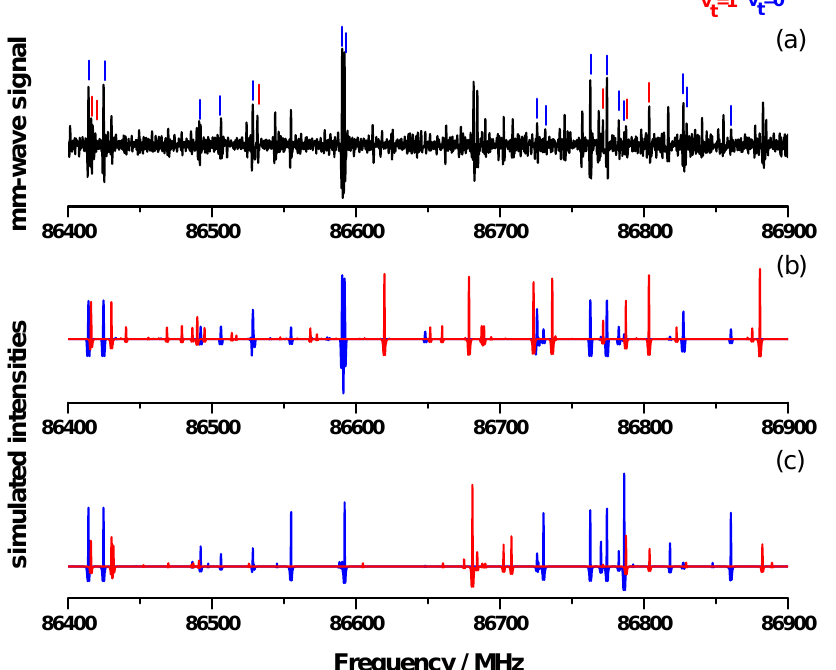
Figure 2. ( a ) Experimental mm-wave spectrum of 2-MF measured in this work (black) in the 86.4–86.9 GHz frequency range. Blue and red sticks correspond respectively to assigned v t = 0 and v t = 1 lines in Ref. [12]. ( b ) Simulated spectrum with the v t = 0 (blue) and v t = 1 (red) parame- ters fitted in Ref. [12] using ERHAM (local approach). ( c ) Simulated spectrum of the present work with the v t = 0 (blue) and v t = 1 (red) using BELGI -C s (global approach) and the fitted parameters from Table